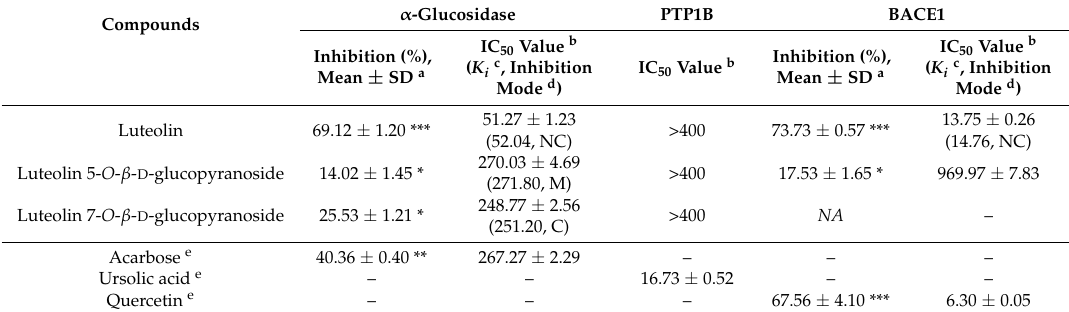
Table 3. Anti-diabetic and anti-Alzheimer’s disease activity of luteolin and its